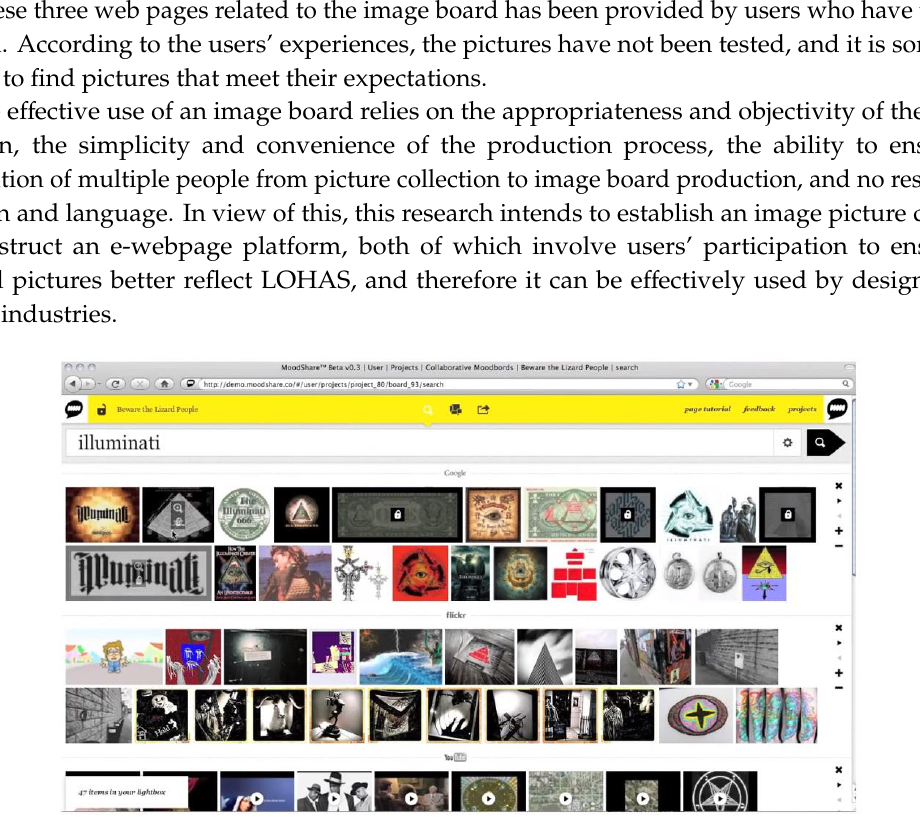
Figure 3. Image board production process using Moodshare.